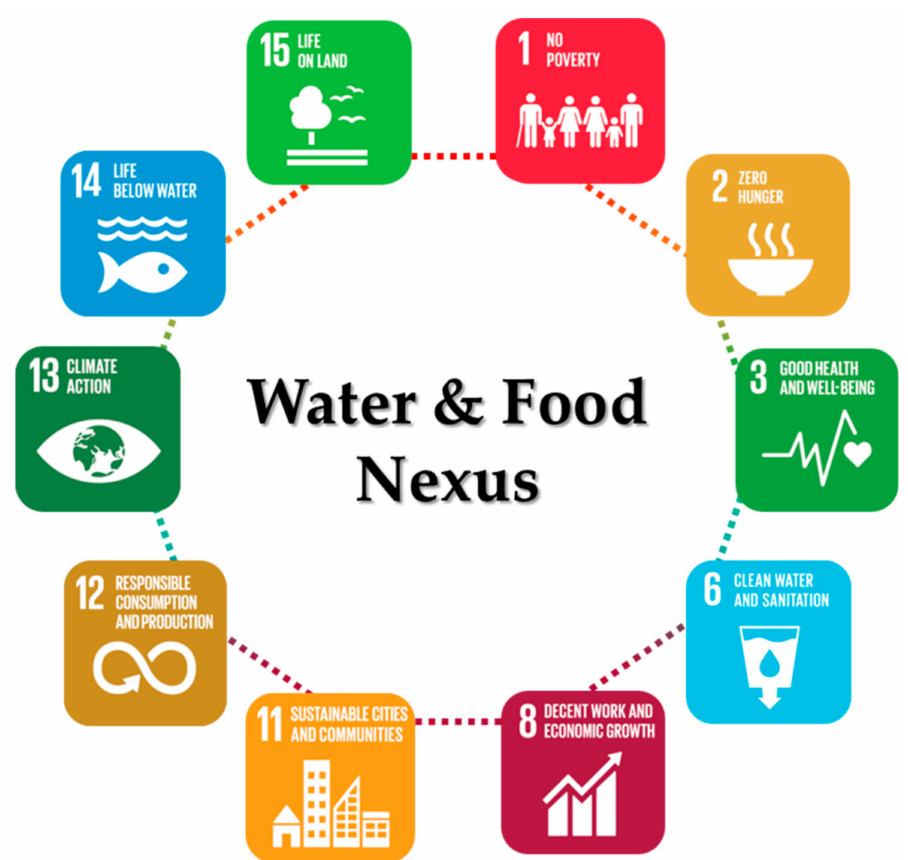
Figure 1. Interaction between the Water–Food Nexus and United Nations’ Sustainable Develop- ment Goals.